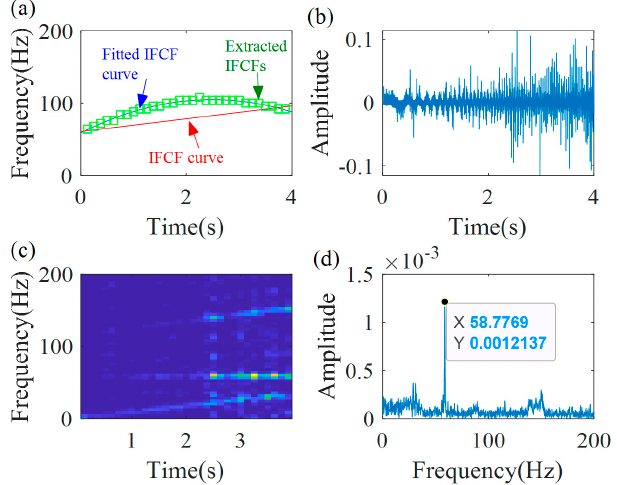
Figure 19. Second iteration demodulation results: ( a ) extracted IFs; ( b ) demodulated signal; ( c ) TFR; and ( d ) spectrum.